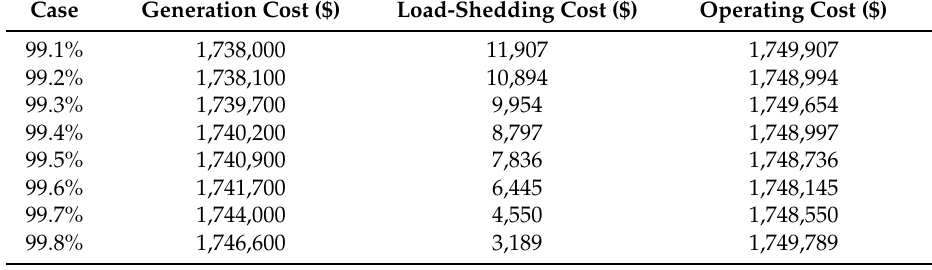
Table 2. The calculated costs for various short-term reliabilities of balance in the range 99.1%–99.8%.